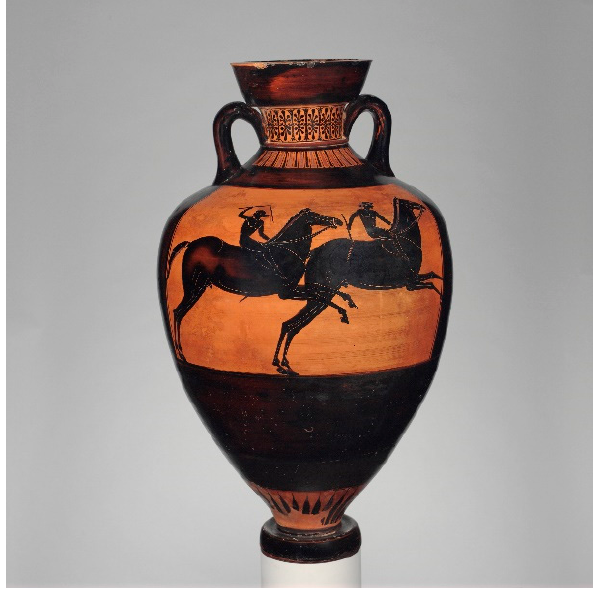
Figure 13. Panathenaic Prize Amphora attributed to the Eucharides Painter. Ca. 490 BCE. Metropoli- tan Museum of Art. Fletches Fund, 1956. Inv. no. 56.171.3.